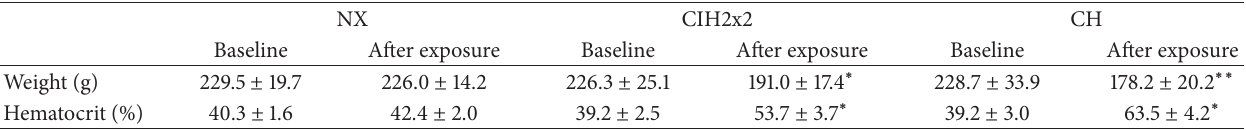
Table 1: Weight and hematocrit in rats exposed to normoxia (NX), chronic intermittent hypoxia (CIH2x2), and chronic hypoxia (CH) at day 0 (baseline) and day 30 (after exposure). Data are expressed as means ± standard error (SE), and differences were obtained by repeated measures ANOVA; ∗ 𝑝 < 0.01 ; ∗∗ 𝑝 < 0.001 compared with the baseline. NX CIH2x2 CH Baseline After exposure Baseline After exposure Baseline After exposure Weight (g) 229.5 ± 19.7 226.0 ± 14.2 226.3 ± 25.1 191.0 ± 17.4 ∗ 228.7 ± 33.9 178.2 ± 20.2 ∗∗ Hematocrit (%) 40.3 ± 1.6 42.4 ± 2.0 39.2 ± 2.5 53.7 ± 3.7 ∗ 39.2 ± 3.0 63.5 ± 4.2